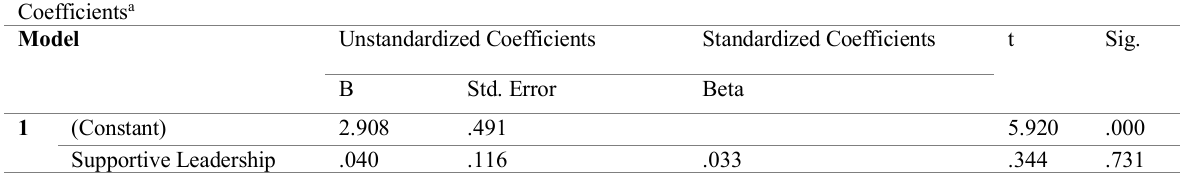
Table 5: Regression coefficients for supportive leadership style